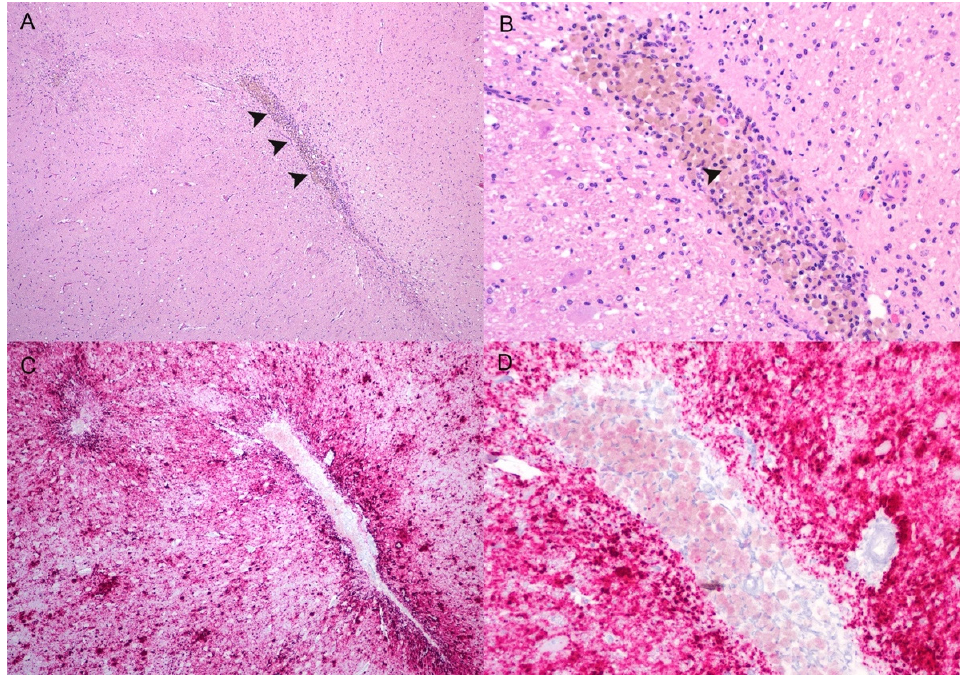
Figure 5. Neuroinflammation and necrosis at the level of the thalamus. ( A ) The neuroparenchyma is disrupted by a linear tract with a cellular infiltrate and necrosis (arrowheads). ( B ) A higher magnification of the same area from panel ( A ). The predominate inflammatory cells are gitter cells that contain golden-brown pigment (arrowhead); an increase in microglia and astrocytes is also present. Small- and medium-sized blood vessels have hypertrophied smooth muscle and endothelium. ( C , D ) Dense aggregates of PrP Sc (red) surround the focal areas of necrosis and inflammation. The lesions and PrP Sc immunolabeling are vasculocentric. There is intracytoplasmic PrP Sc within gitter cells. ( A , B ) Hematoxylin and eosin. ( C , D ) Immunohistochemistry, F99 monoclonal antibody. Original magnification ( A , C ) 100 × ; ( B , D ) 200 ×